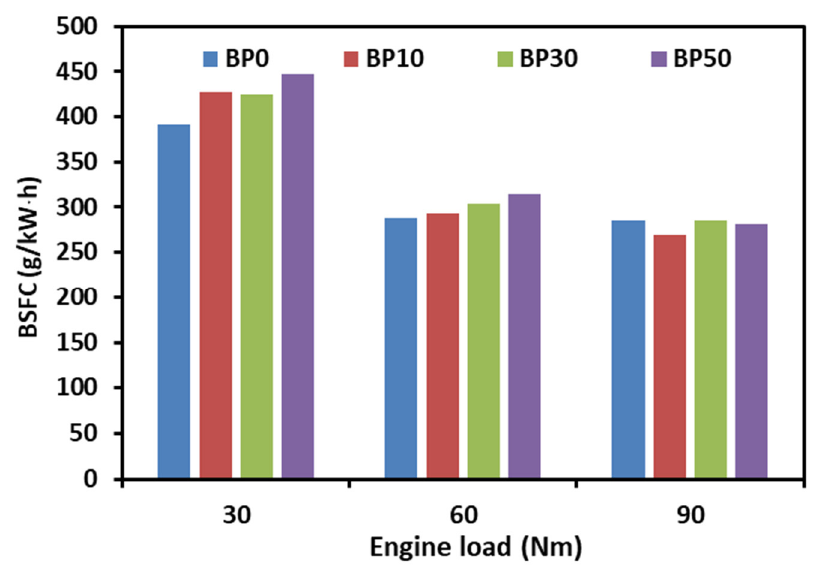
Figure 7. BSFC for all test fuels according to various engine